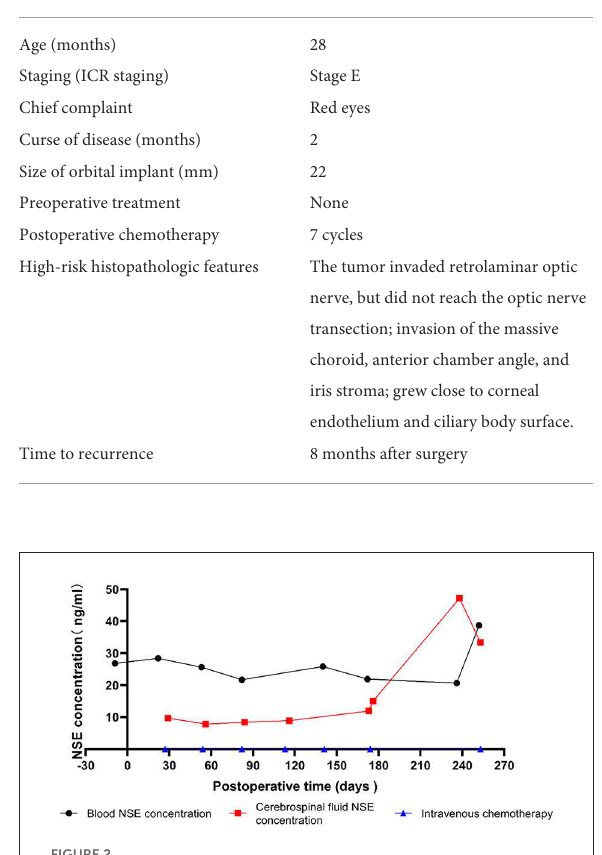
TABLE 1 Clinical features of 59 children with optic nerve invasion RB. TABLE 2 Clinical characteristics of patient that died.